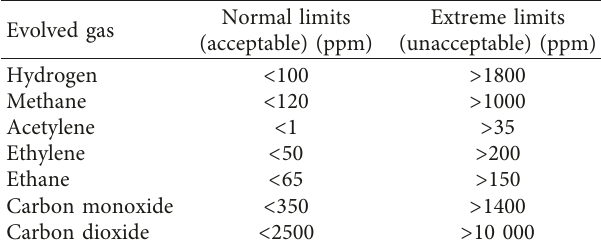
Table 4: IEEE DGA limits [2].